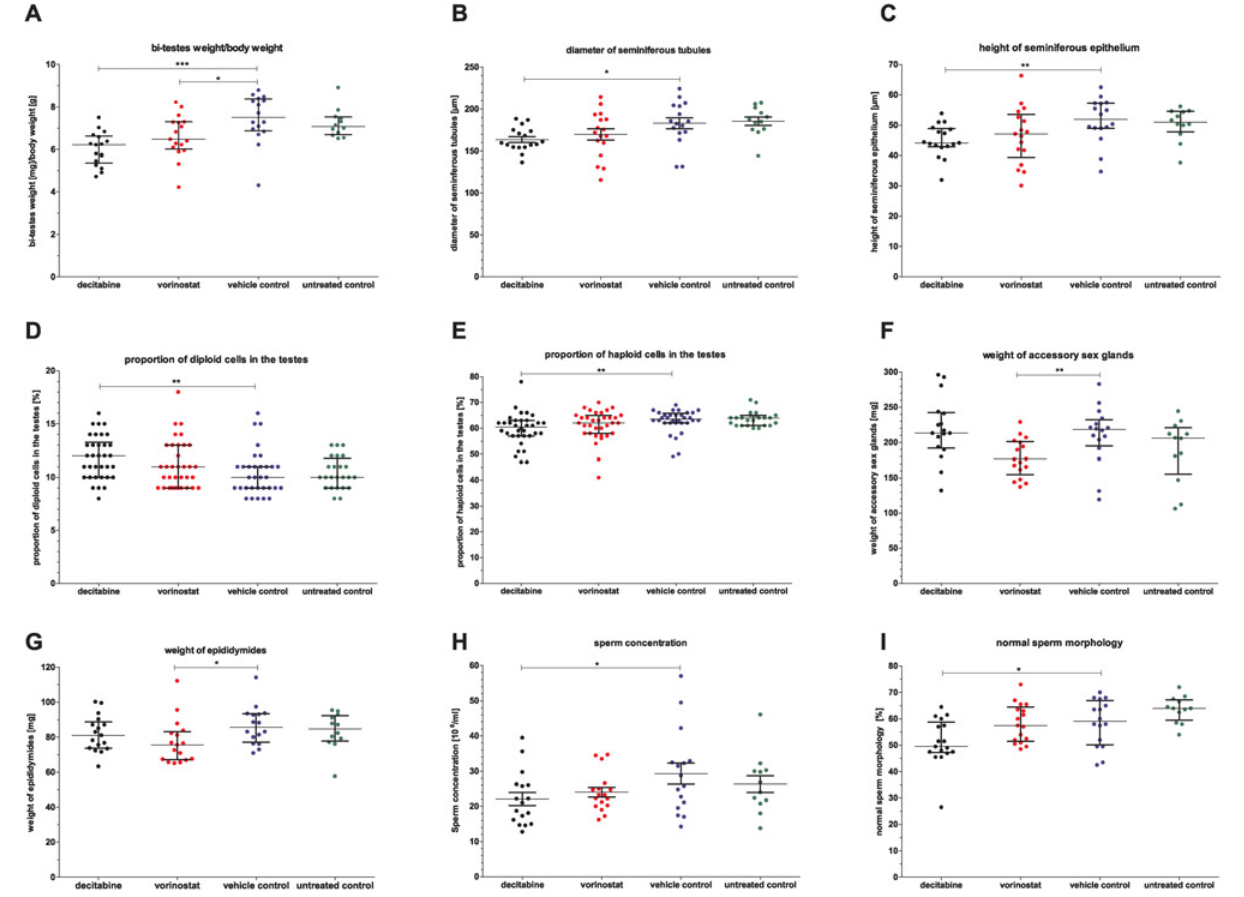
Fig 2. Direct effects of decitabine and vorinostat treatment on reproductive organs and semen parameters. A) Bi-testes weight/body weight, B) diameter of seminiferous tubules, C) height of seminiferous epithelium, D) percentage of diploid cells (undifferentiated germ cells and somatic cells) and E) of haploid cells (spermatids) in the testes, F) weight of accessory sex glands, G) weight of epididymides, H) sperm concentration and I) morphology. One point represents one animal. A), C) — G), I) The median ( ± interquartile range) or B), H) mean ( ± SEM) are shown, * : p < 0.05, ** : p < 0.01, *** : p < 0.001.